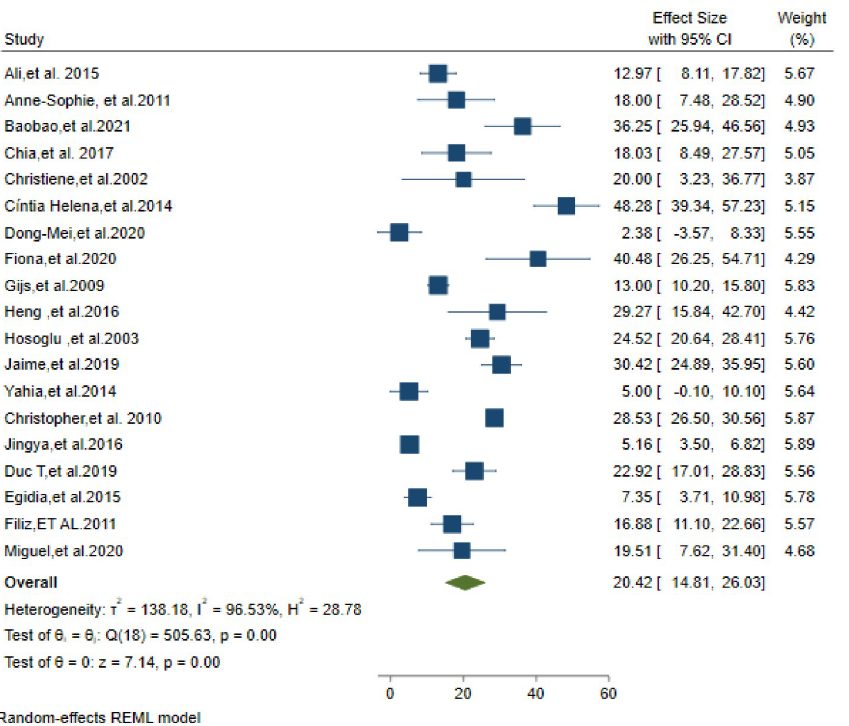
Fig 6. Mortality among Tuberculosis meningitis suspected